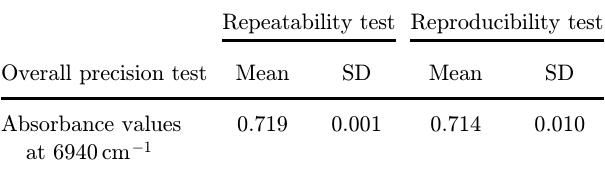
Table 4. Overall precision test. Repeatability test Reproducibility